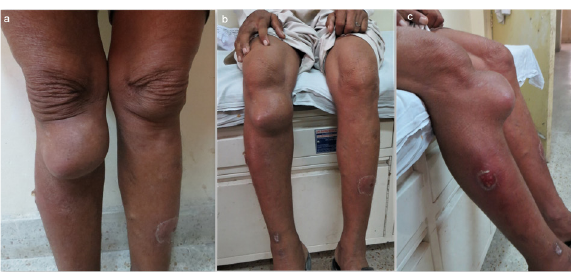
Figure 1. The clinical picture showing a huge swelling below right patella from front standing (a) and on sitting (b). The swelling is associated with adjacent cellulitis in lateral leg (c).